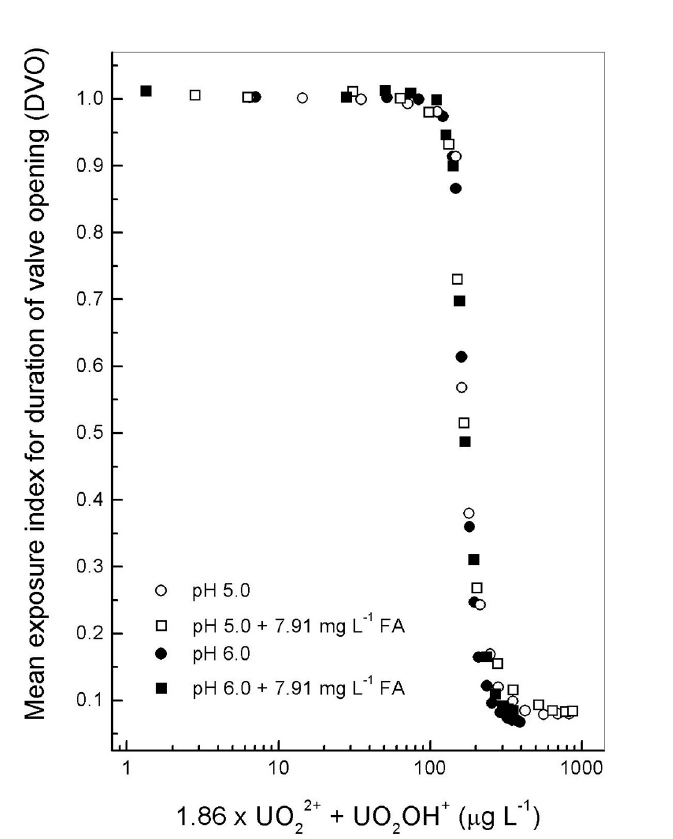
FIGURE 5. Concentration-response relationships of the DVO for V. angasi expressed in terms of the activities of UO 22+ and UO 2 OH + at pH 5 and 6 with and without model FA (7.9 mg l -1 ). Each plotted point represents the mean response of six bivalves. Error bars and curve fits are excluded for